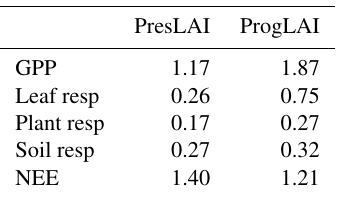
Table 2. Standard deviation of annual global carbon flux for